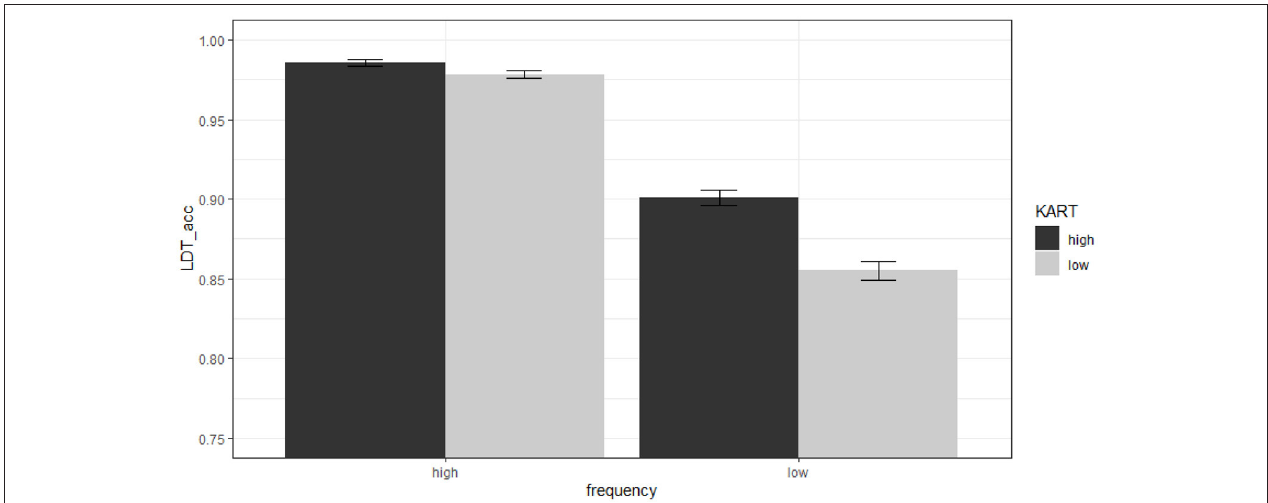
FIGURE 3 | Effects of word frequency and KART scores on accuracy in the lexical decision task. Error bars represent standard error ( SE ) of the mean. Note that word frequency and KART scores were entered into the model as continuous variables in the analyses. They are shown as median splits in the figure for the purposes of illustration.